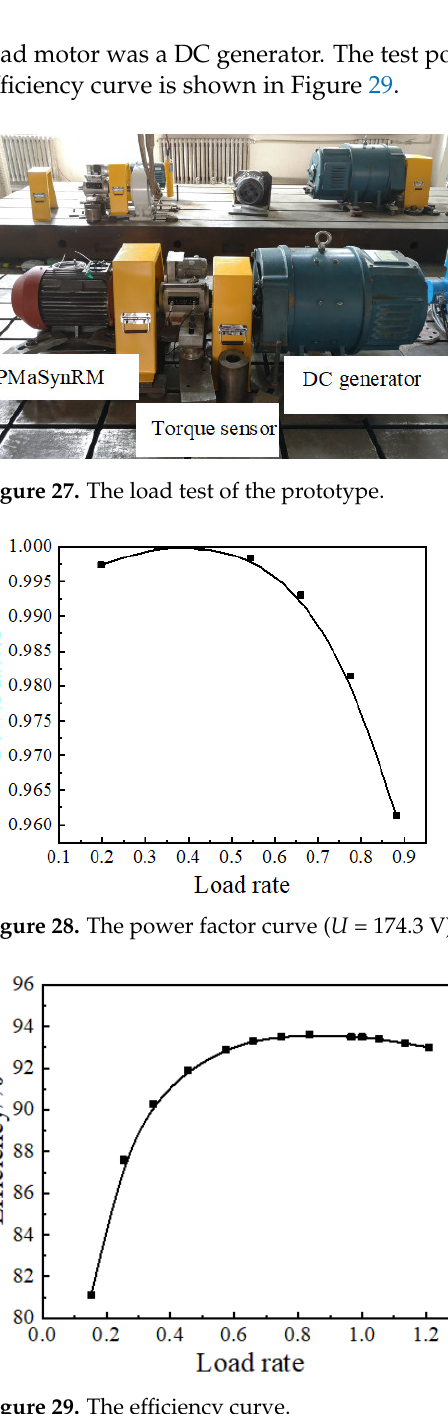
Figure 29. The efficiency curve.